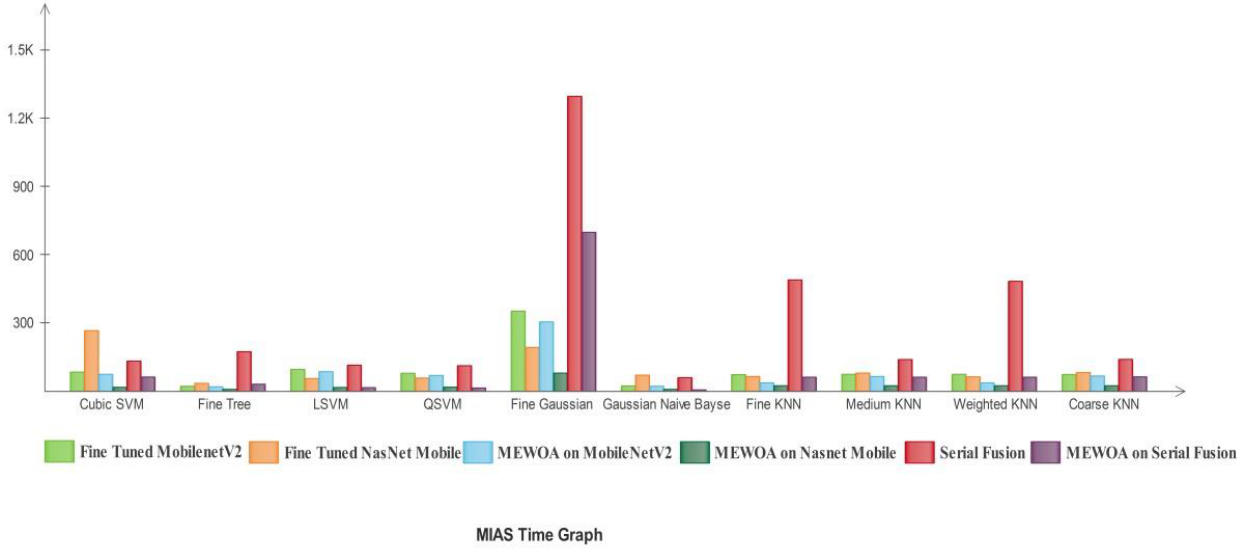
Figure 20. Time compared with individual machine learning classifiers of deep learning models for MIAS.